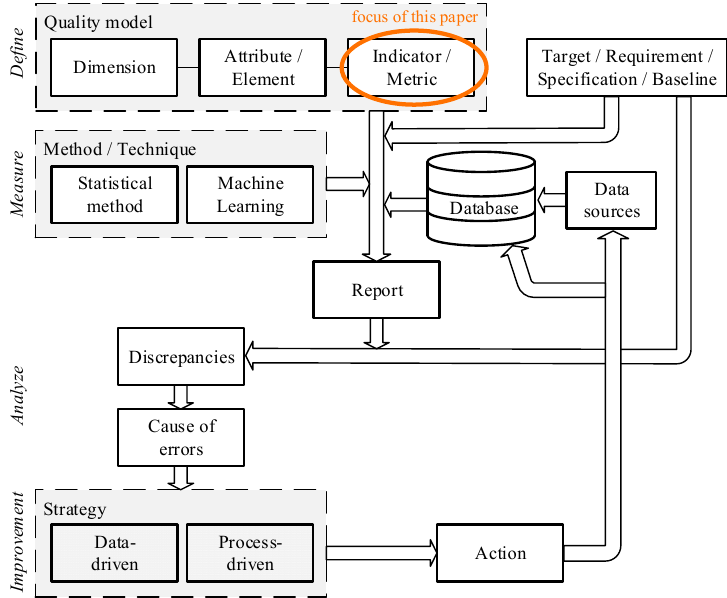
Figure 2. Data quality assessment process. The main contribution of this paper is highlighted.